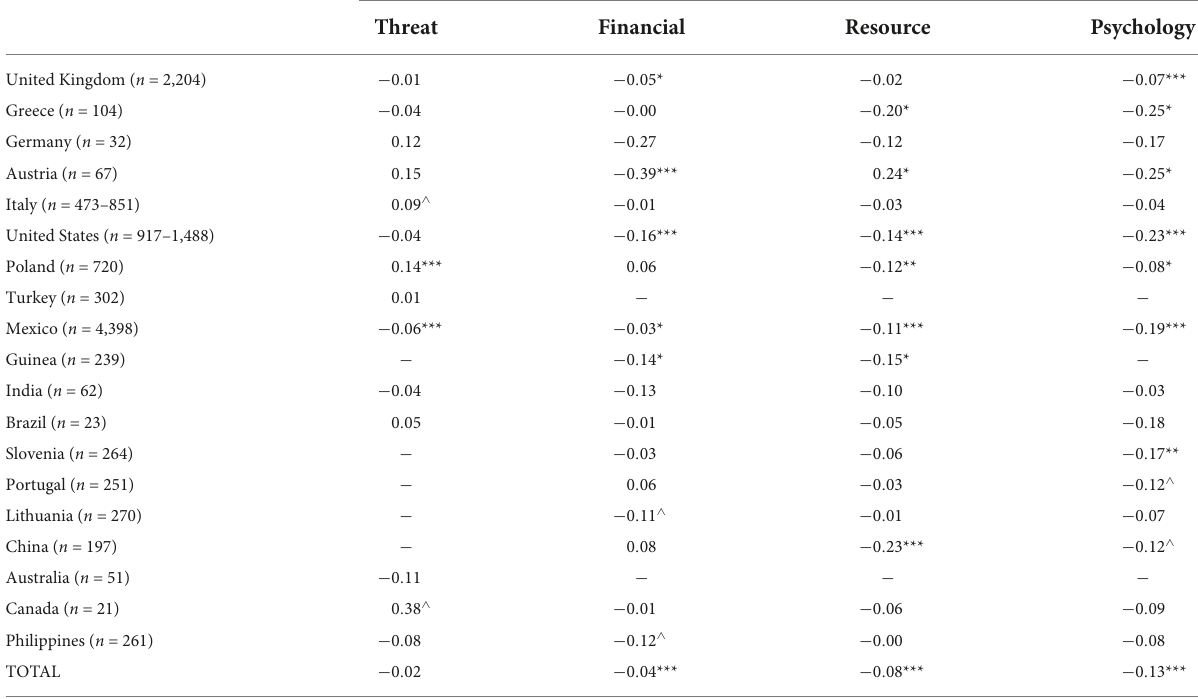
TABLE 2A The relationship of age with perceived COVID-19 threat and impacts across nations. Nation Measure Threat Financial Resource